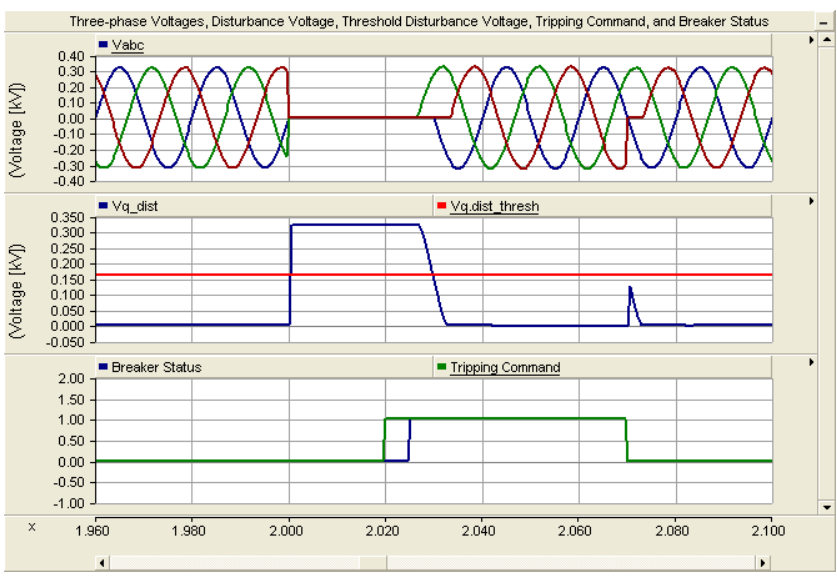
Figure 3. 3-phase voltages, disturbance voltage, and trip signal for fault 1 (F1).